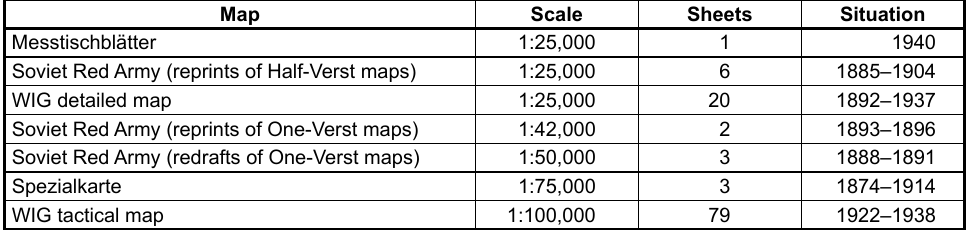
Tab. 2. List of archival topographic maps gathered for cartographic research